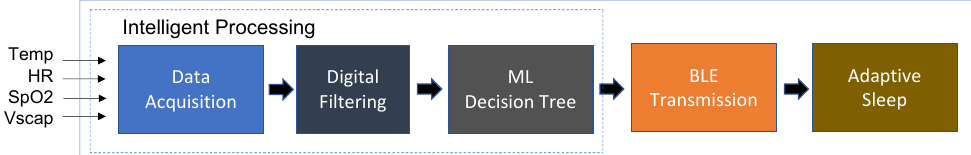
Figure 5. Flowchart diagram of the DPM